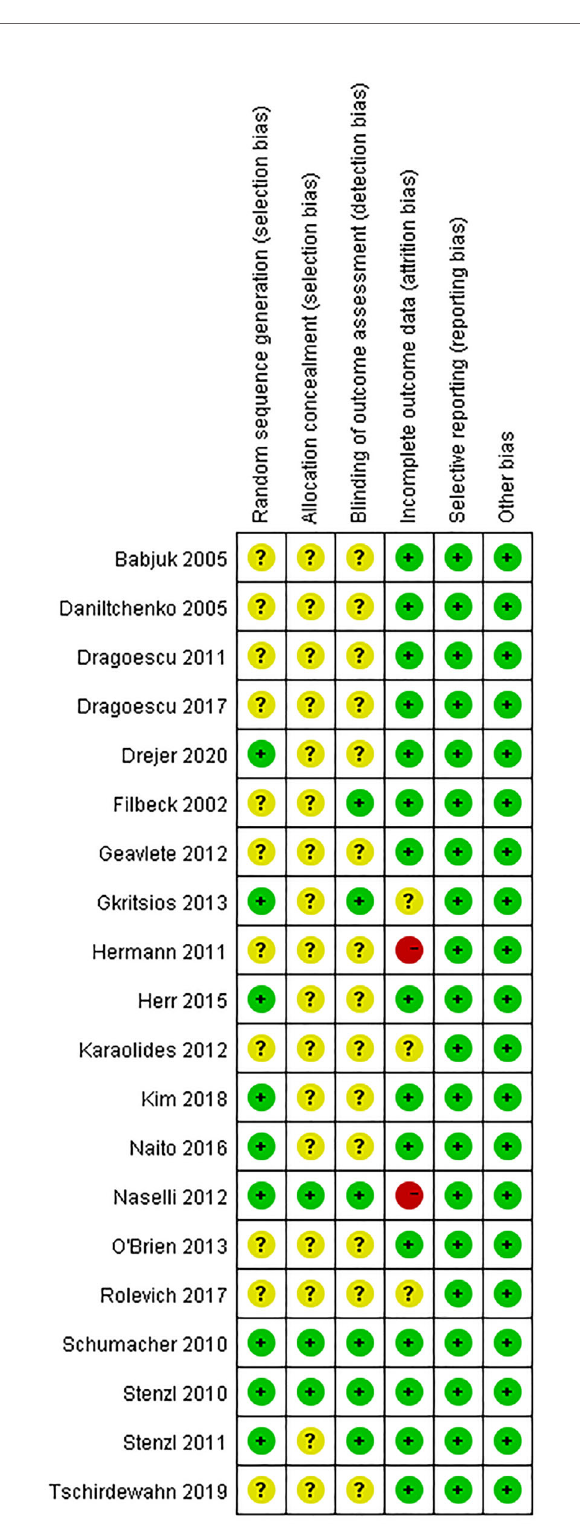
FIGURE 2 | Risk of bias summary: review authors ’ judgements about each risk of bias item for each included